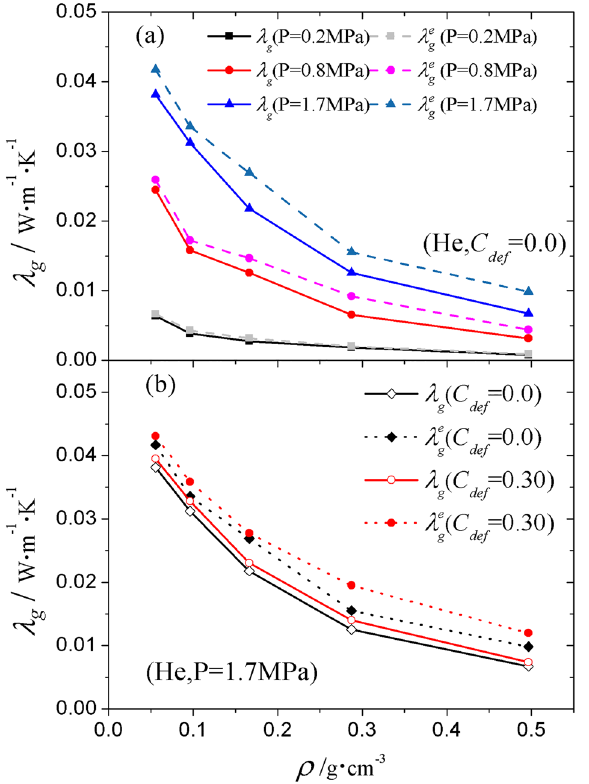
Figure 9. Effective gas thermal conductivity (cid:31) e g of He as a function of ( a ) gas pressure and ( b ) defect concentration C def . For clarity, the results for perfect ( C def = 0) and defective structures were aligned to the same ρ